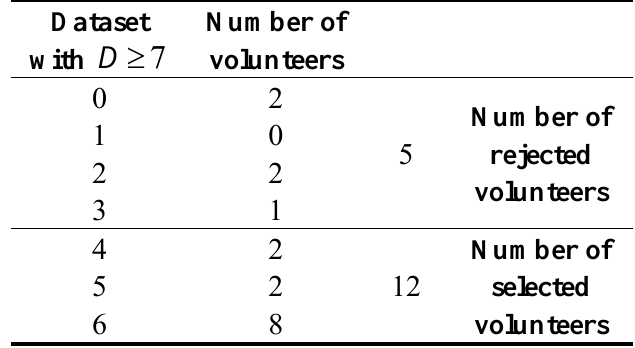
Table 2. Subdivision of volunteers based on quality